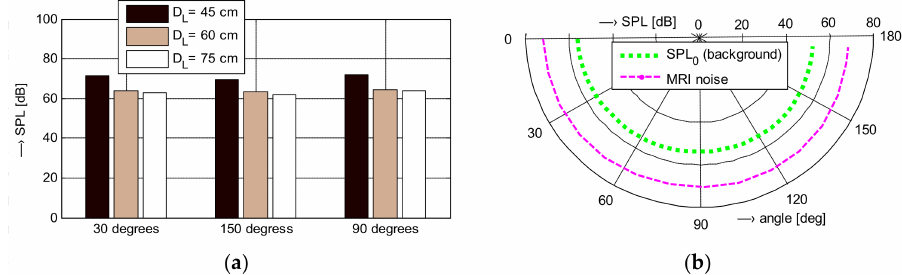
Figure 3. Visual comparison of obtained noise SPL values; ( a ) measured in the directions of 30 ◦ , 90 ◦ , and 150 ◦ at the distances of D L = {45, 60, 75} cm; ( b ) measured directional patterns of the noise source and the background noise SPL 0 , D L = 60